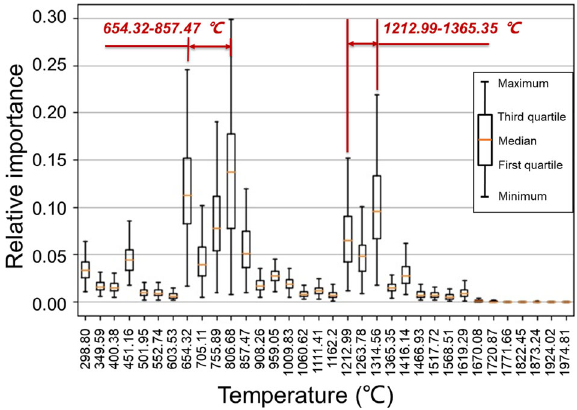
Fig. 8 Relative importance spectrum of temperature intervals for UTS. We randomly split the total dataset 150 times to obtain statistical bars for the relative importance spectrum, including maximum, third quartile, median, fi rst quartile, and minimum. Each statistical bar indicates the relative importance of a temperature range between the value on the x -axis and that value plus the temperature interval (50.88